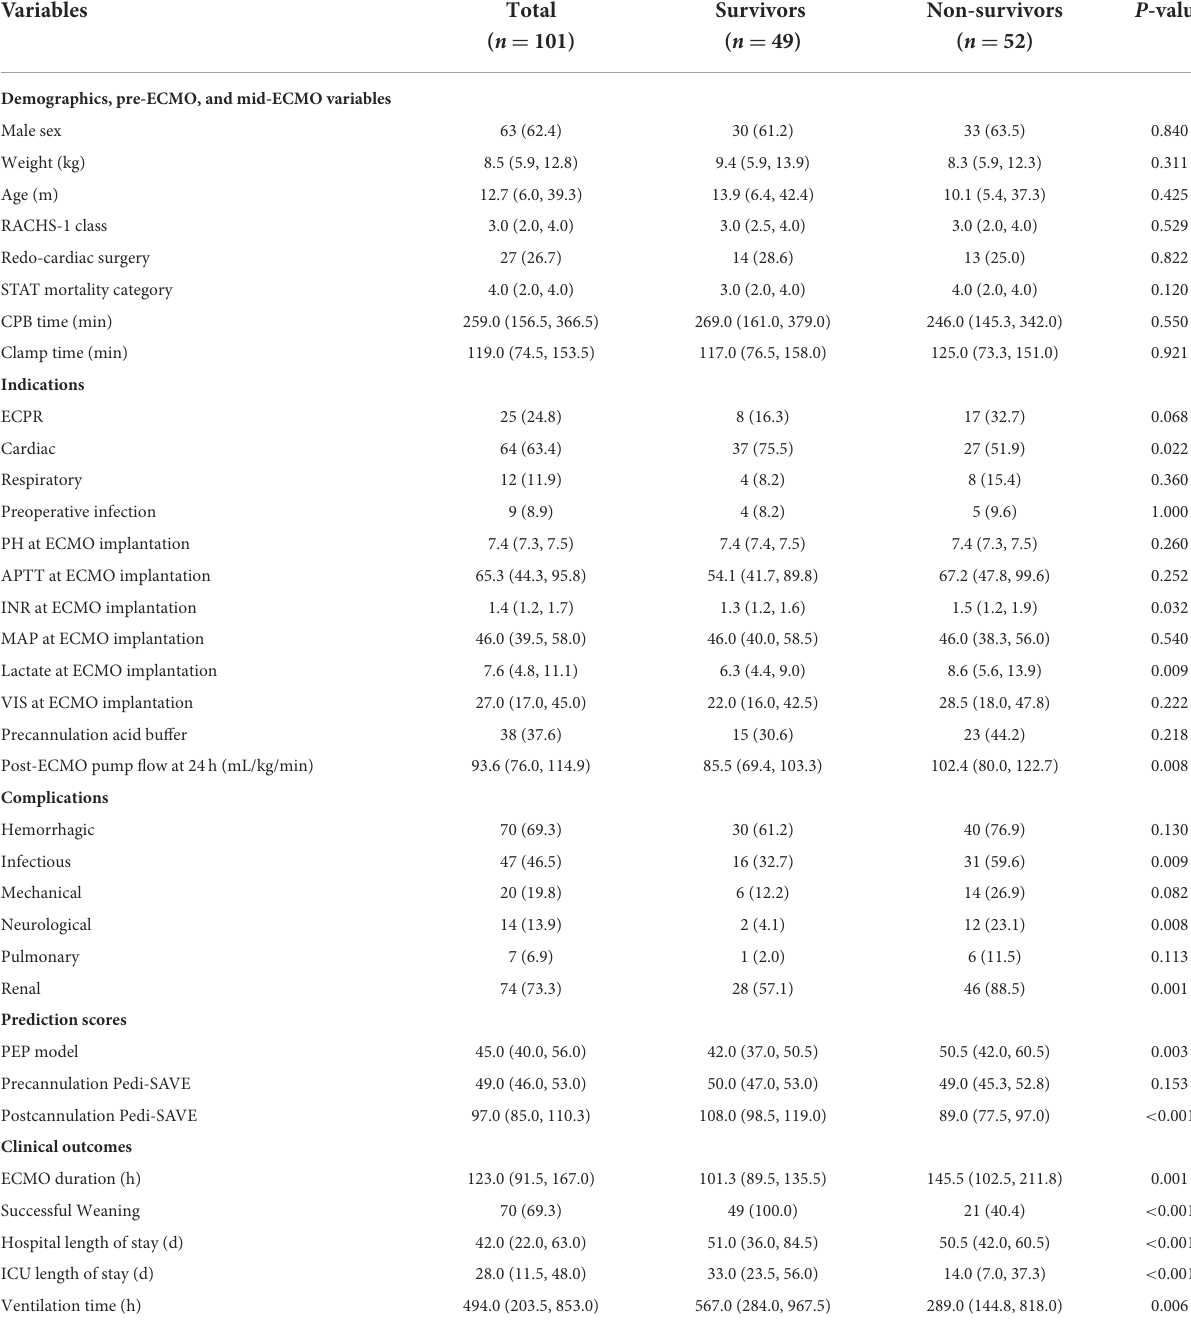
TABLE 2 Patient characteristics of survivors and